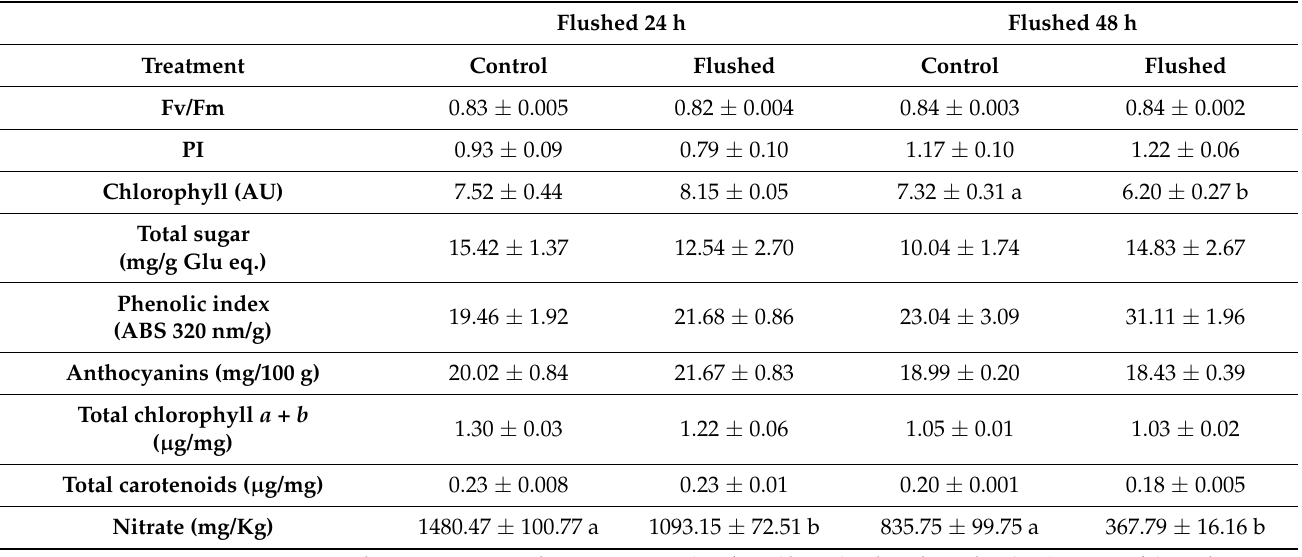
Table 1. Quantitative and qualitative parameters measured at the harvest of treated and untreated Lactuca sativa samples.